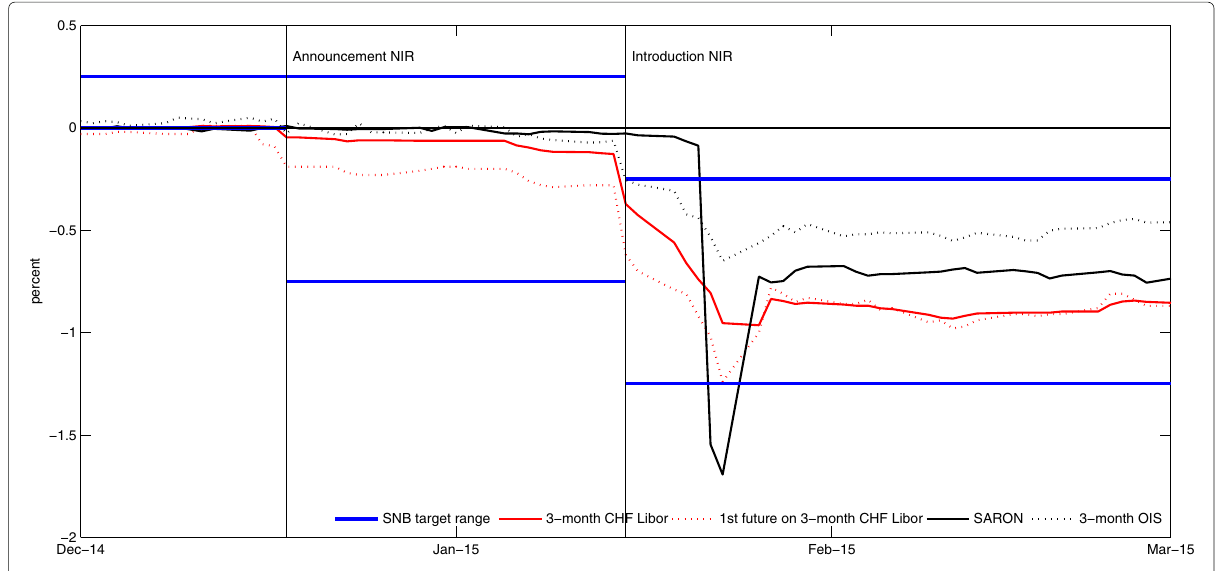
Fig. 2 CHF money market interest rates after the announcement (15 January 2015) and introduction of negative interest rates (22 January